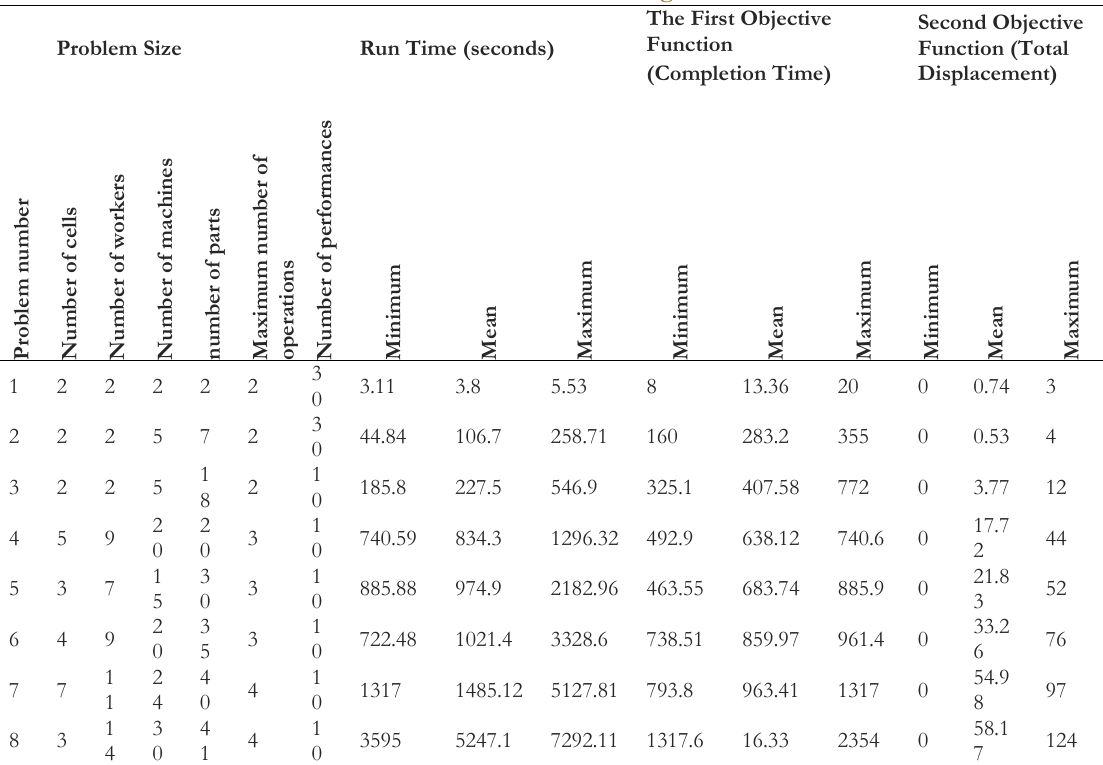
Table 10. Results of MO-TS-GA